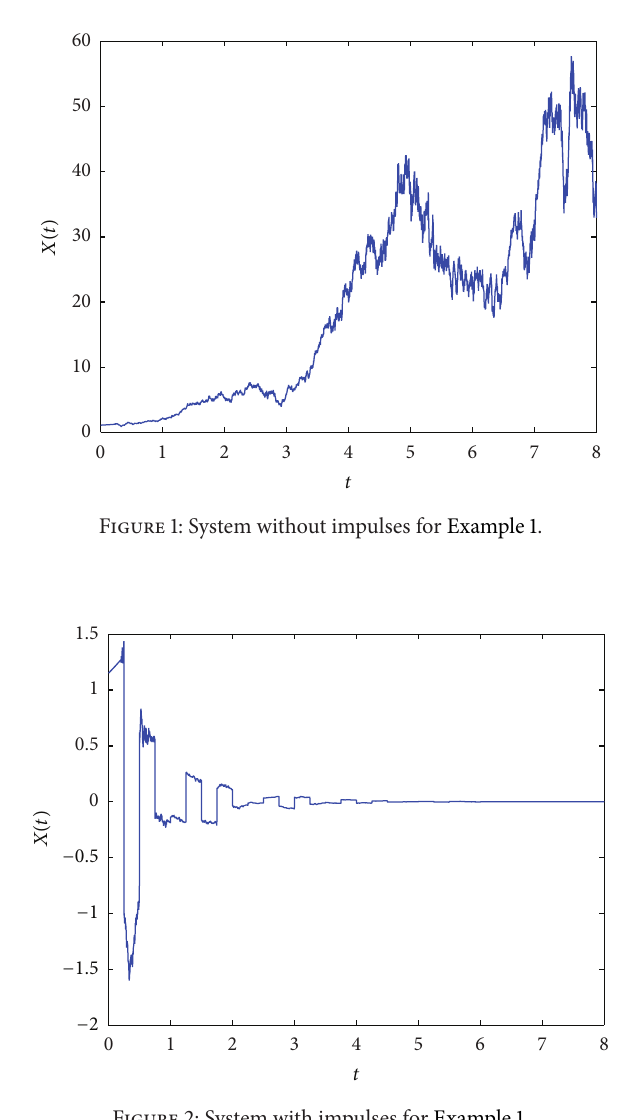
Figure 2: System with impulses for Example